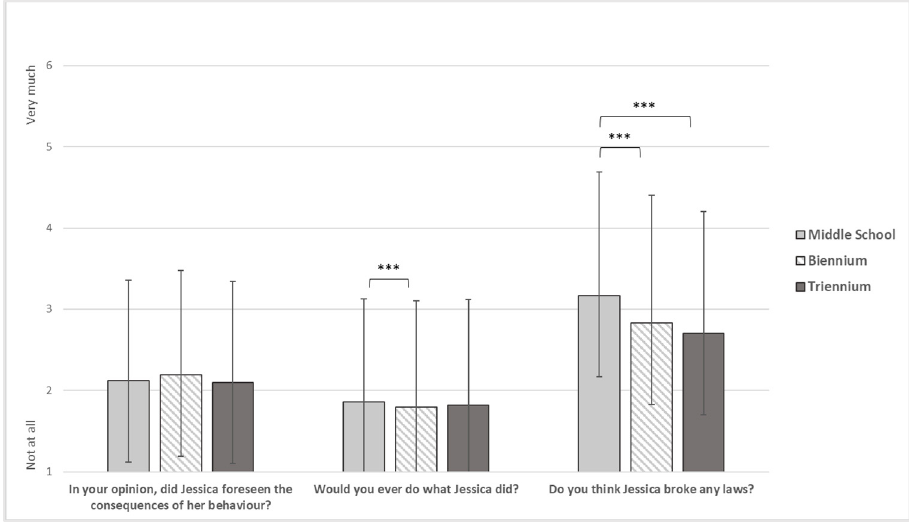
Figure 3. Victim-blaming. Note. *** = p < 0.001.